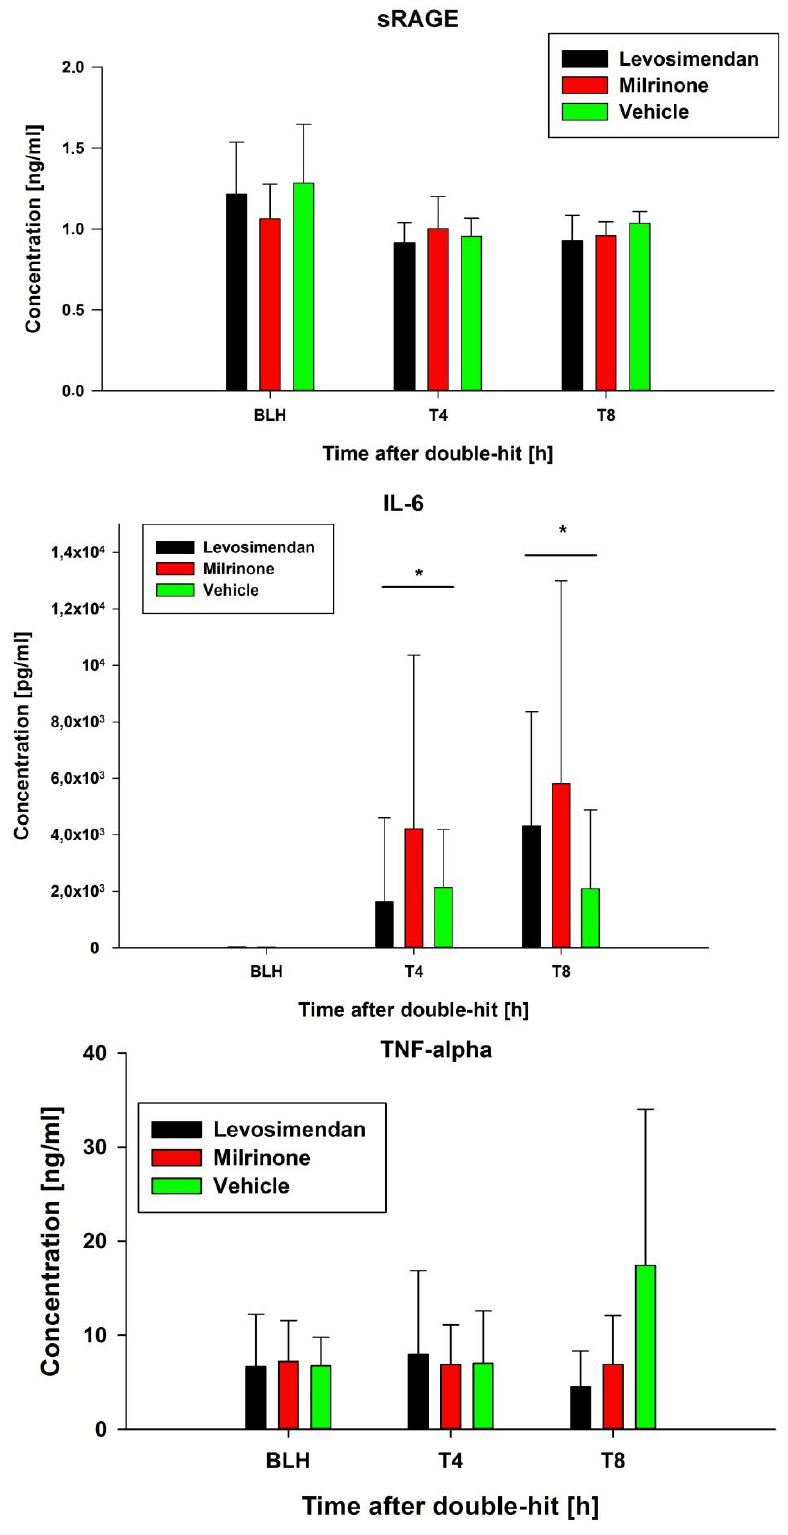
Figure 4. Blood sample analysis of inflammatory markers. * indicates p < 0.01 sham/milrinone/levosimendan for IL-6 for T4/T8 vs. BLH. sRAGE: soluble receptor for advanced glycation; IL-6: Interleukin-6. BLH: baseline healthy. Tx: timepoint. The pulmonary tissue mRNA expression revealed a significant upregulation of COX-2 ( p < 0.05 levosimendan vs. milrinone; Figure 5).